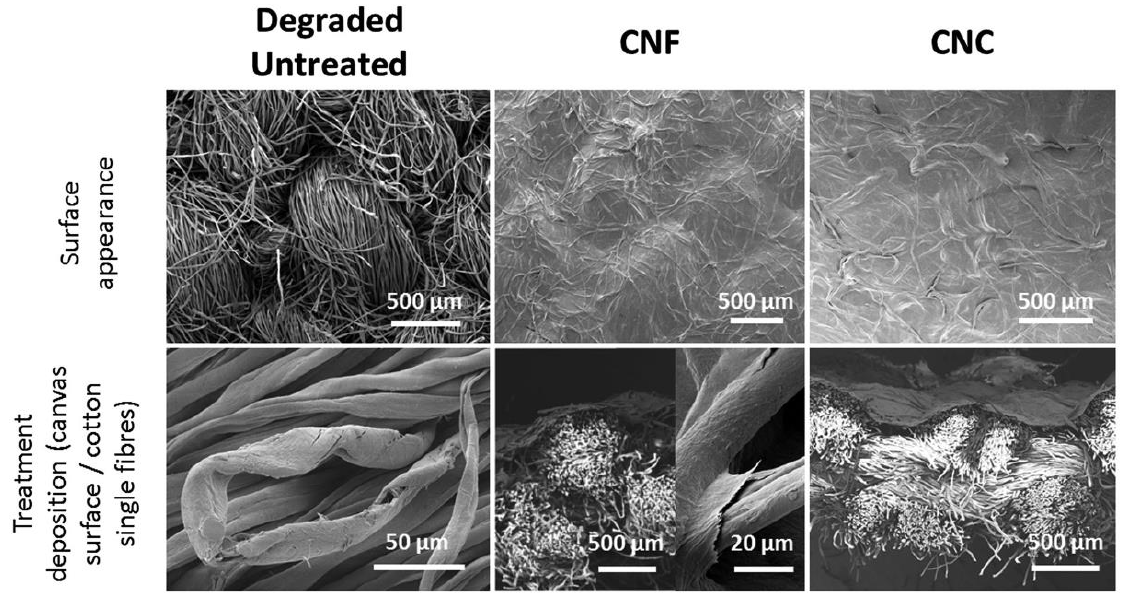
Figure 4. SEM images showing the canvas surface topography before and after treatment. Repro- duced with permission [19]. Copyright © 2018, Taylor & Francis.